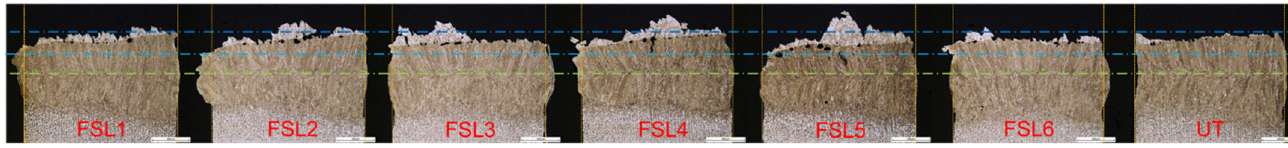
Figure 12. Fracture images from the front of the seam.